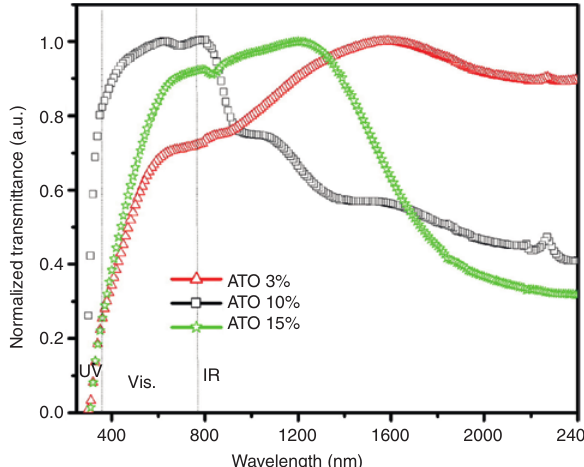
Figure 6: UV-visible-near infrared radiation (UV-Vis-NIR) normalized transmittance spectra of as-sintered antimony-doped tin oxide (ATO) nanoparticles (NPs) thin films at various Sb doping concentrations of 3%, 10% and